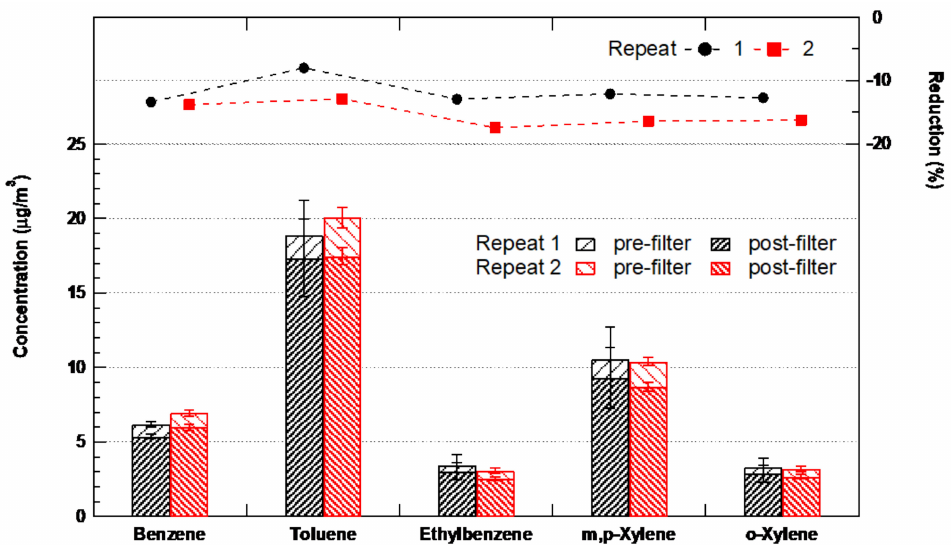
Figure 11. Measured BTEX concentrations at pre- and post-filter locations without cabin filters. Uncertainties are 95% confidence interval error estimates. Dotted lines indicate the reductions in BTEX concentrations at the post-filter location for the different repeats.